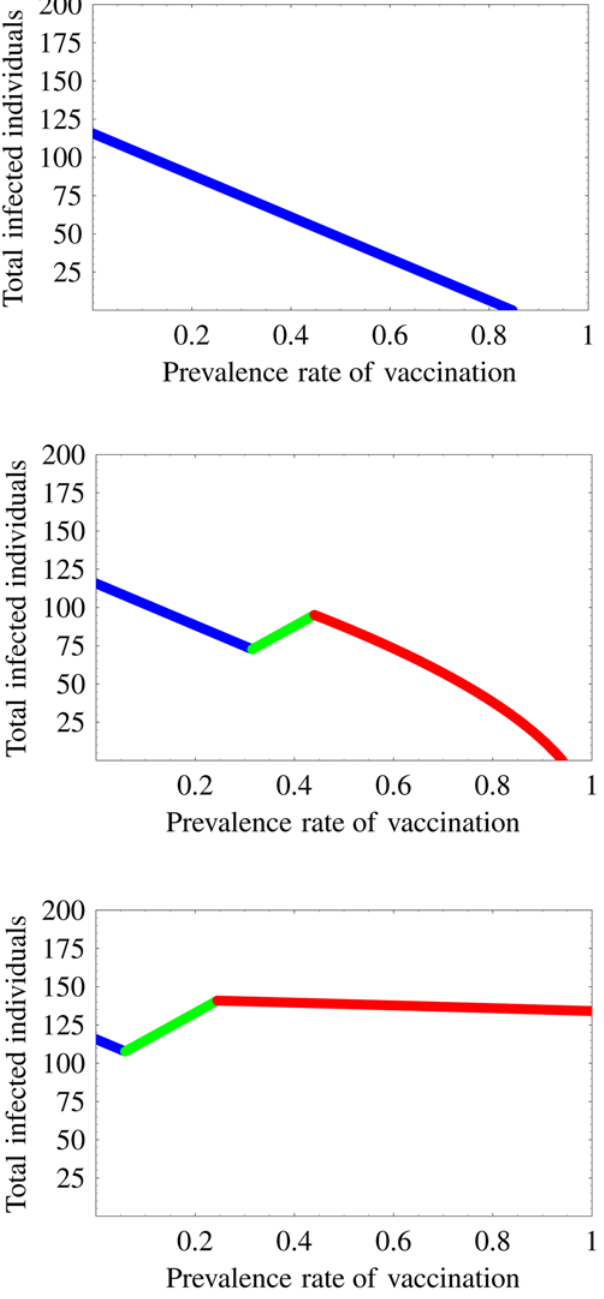
Figure 3. Impact of the loss of the protection effectiveness of the vaccination on the change of the final size of the epidemic: The losses of the protection in the top, middle, and bottom figure are s =0.05, 0.15, and 0.8, respectively. The top (0 # s # s * ) and middle ( s (cid:1) ƒ s ƒ s ) figures portray the possibility of eradication of the infectious disease through the vaccination program. However, in the bottom figure ( s ƒ s ƒ 1 ), the vaccination engenders a failure to prevent the spread of the disease. The patterns of the change are divisible into these three cases, depending on the loss of the protection. The blue, green, and red lines respectively correspond to the situation in which only the vaccine-sensitive strain exists, both the vaccine- sensitive and the vaccine-resistant strains exist, and only the vaccine- resistant strain exists.